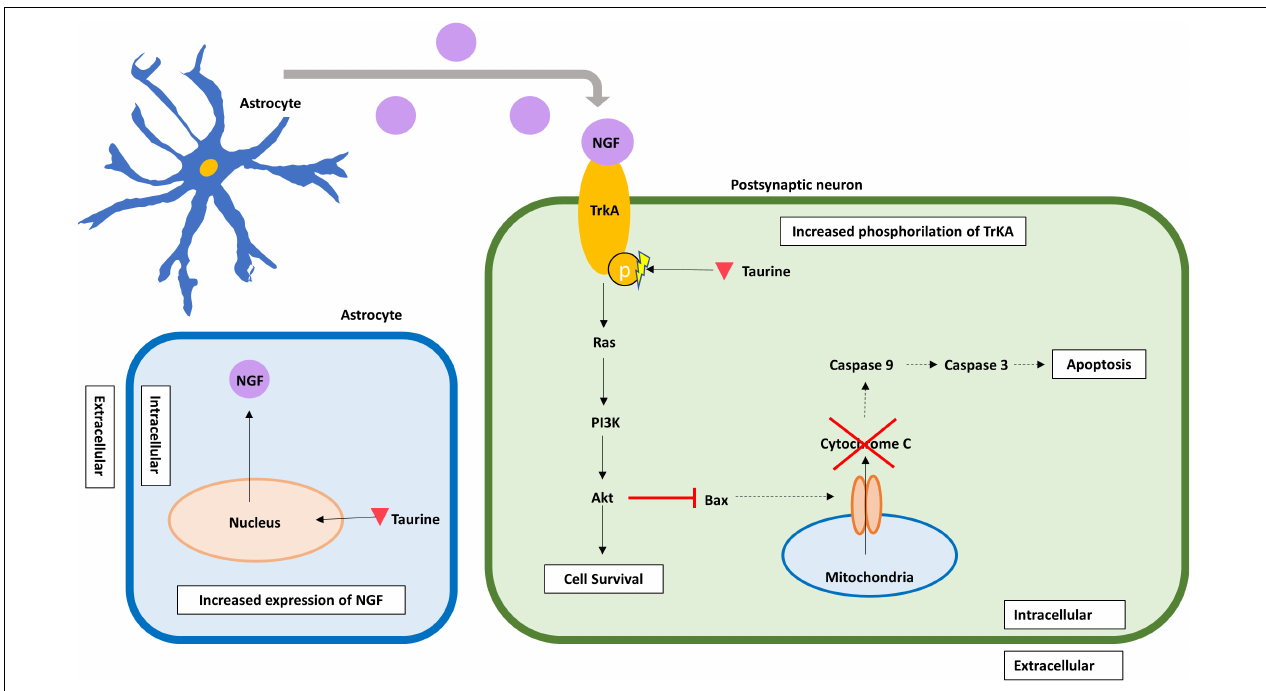
FIGURE 3 | Delayed neuroprotective effects of taurine in the post-synaptic neuron. Taurine increases the expression of NGF, presumably in astrocytes from where it is released. Additionally, intracellular taurine increases phosphorylation of TrkA, a specific receptor for NGF, thus enhancing the NGF/Akt/Bad anti-apoptotic pathway. By activating this pathway, taurine enhances Bax inhibition, which blocks Cytochrome C release from mitochondria, and inhibits caspase-mediated apoptotic pathways. Taurine is represented by an inverted red triangle, while NGF is represented by a magenta circle. HD, hypotaurine dehydrogenase; NGF, nerve growth factor; PI3K, phosphatidylinositol 3-kinase; TrkA, tropomyosin receptor kinase